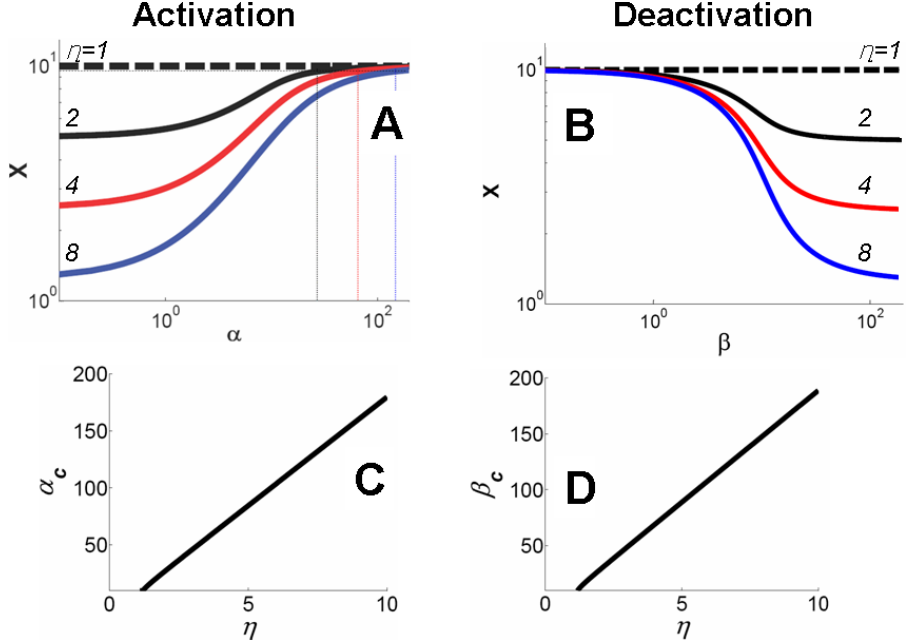
Figure 5. Dynamic range of output activation and deactivation. (A) The dynamic range for activation was g because: X ss < k / g as a R 0; X ss < k as a R ‘ . For a given g , we define a critical value a C that corresponds to an X SS =95% of the maximal value. If a . a C , fluctuations in X ss due